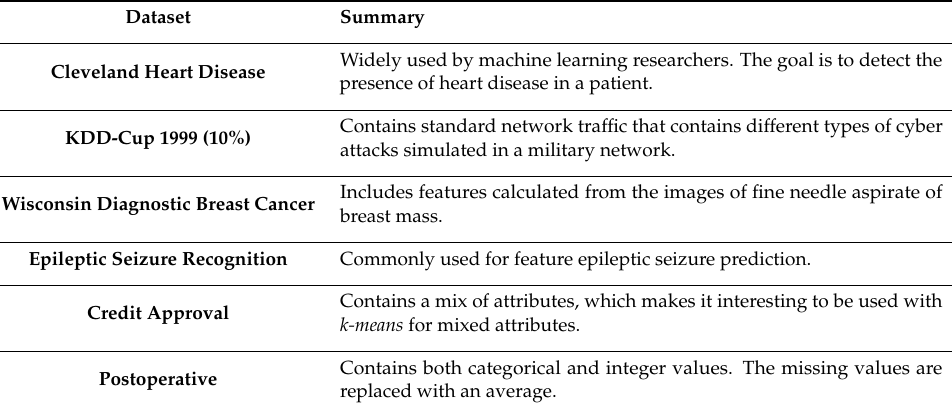
Table 3. Summary of